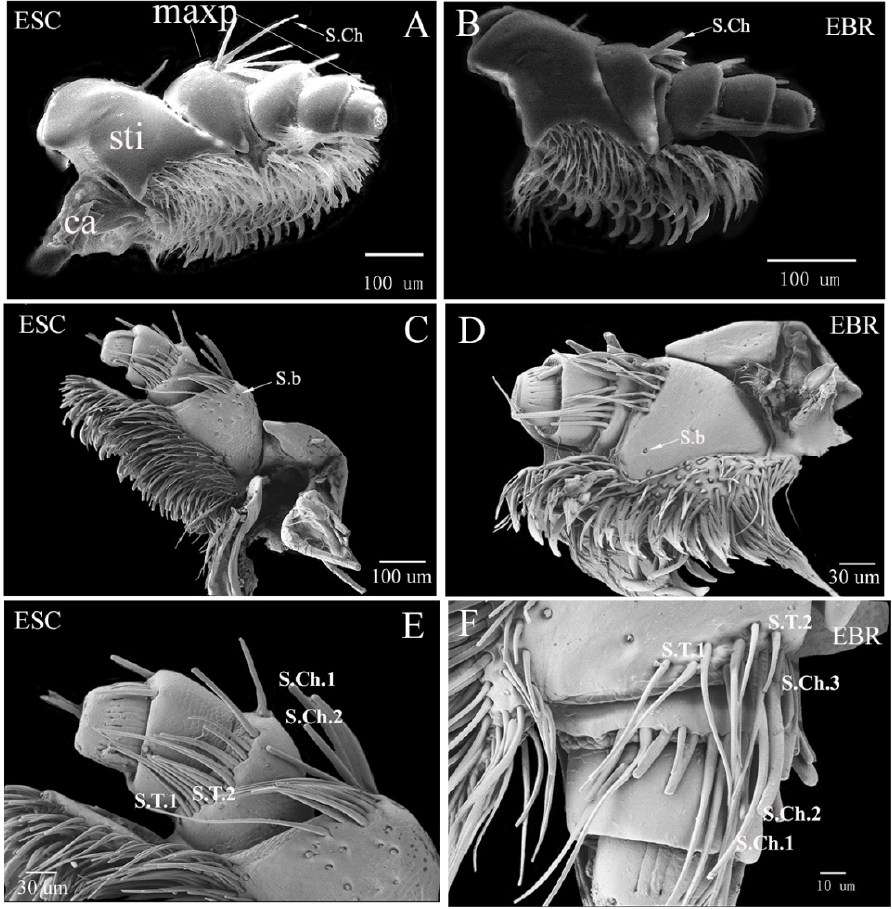
Figure 2. Scanning electron micrographs showing the maxillae of Eucryptorrhynchus scrobiculatus (ESC) females and E. brandti (EBR) females. ( A ) The dorsal of E. scrobiculatus maxillae; ( B ) the dorsal of E. brandti maxillae; ( C ) the ventral of E. scrobiculatus maxillae; ( D ) the ventral of E. brandti maxillae; ( E ) the ventral of E. scrobiculatus maxillary palpi; ( F ) the ventral of E. brandti maxillary palpi. maxp, maxillary palpi; sti, stipe; ca, cardo; S.Ch, sensilla chaetica; S.b, sensilla basiconica; S.T.1-2, sensilla trichodea; S.Ch.1-3, sensilla chaetica.